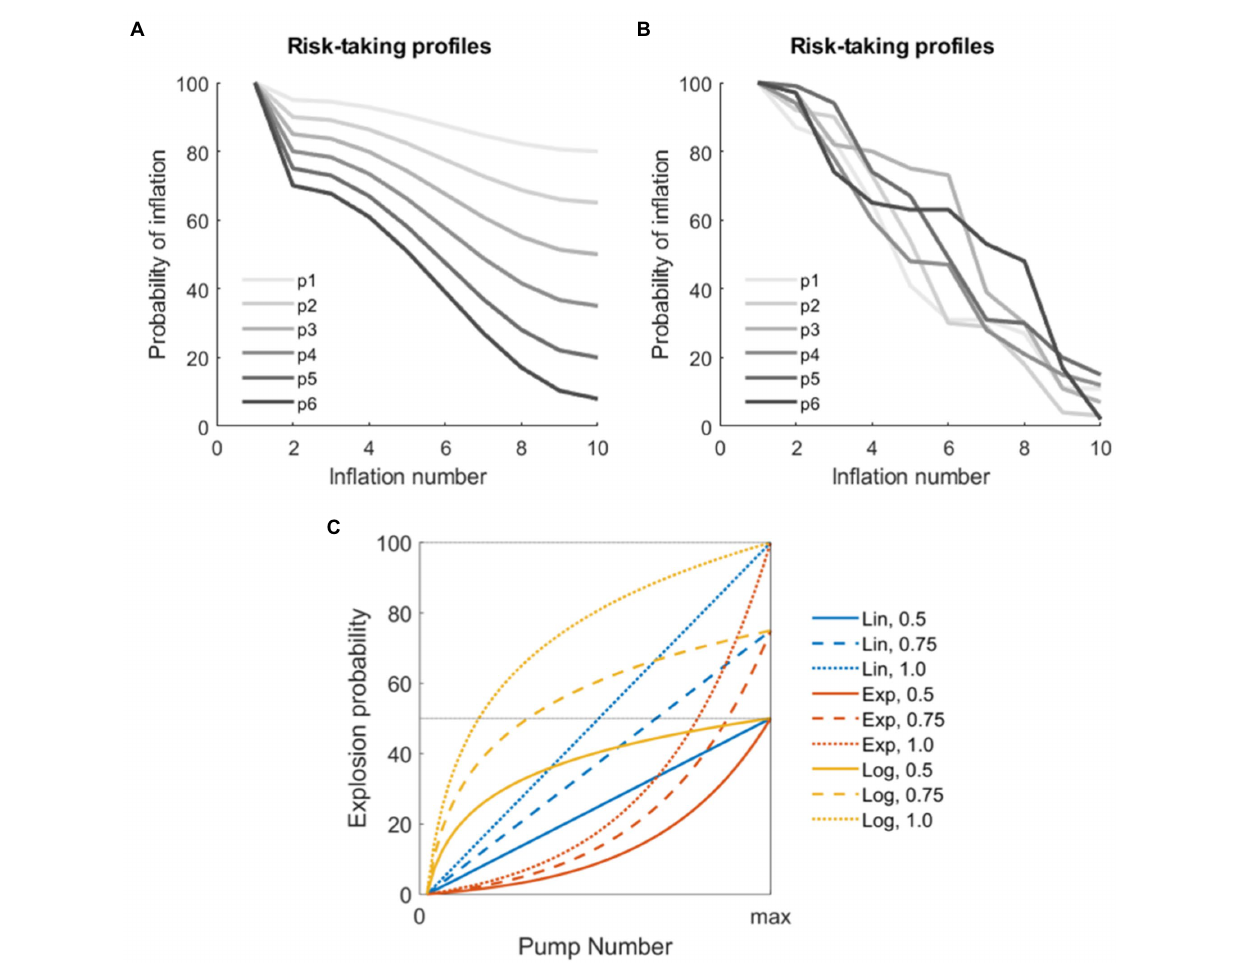
FIGURE 1 | Parameters for the simulation. (A) Examples of virtual players with non-linear decrease in the risk-taking profile modeled using the cosine function. (B) Examples of virtual players with random decrease in the risk-taking profile. (C) Combination of parameters used to model explosions in the different versions of the stochastic Balloon Analog Risk Task (BART) analyzed. The three functions used to model explosion probabilities in consecutive inflations are coded by colors (linear, exponential, and logarithmic). The three thresholds indicating maximum explosion probabilities are coded by the line type (50, 75, and